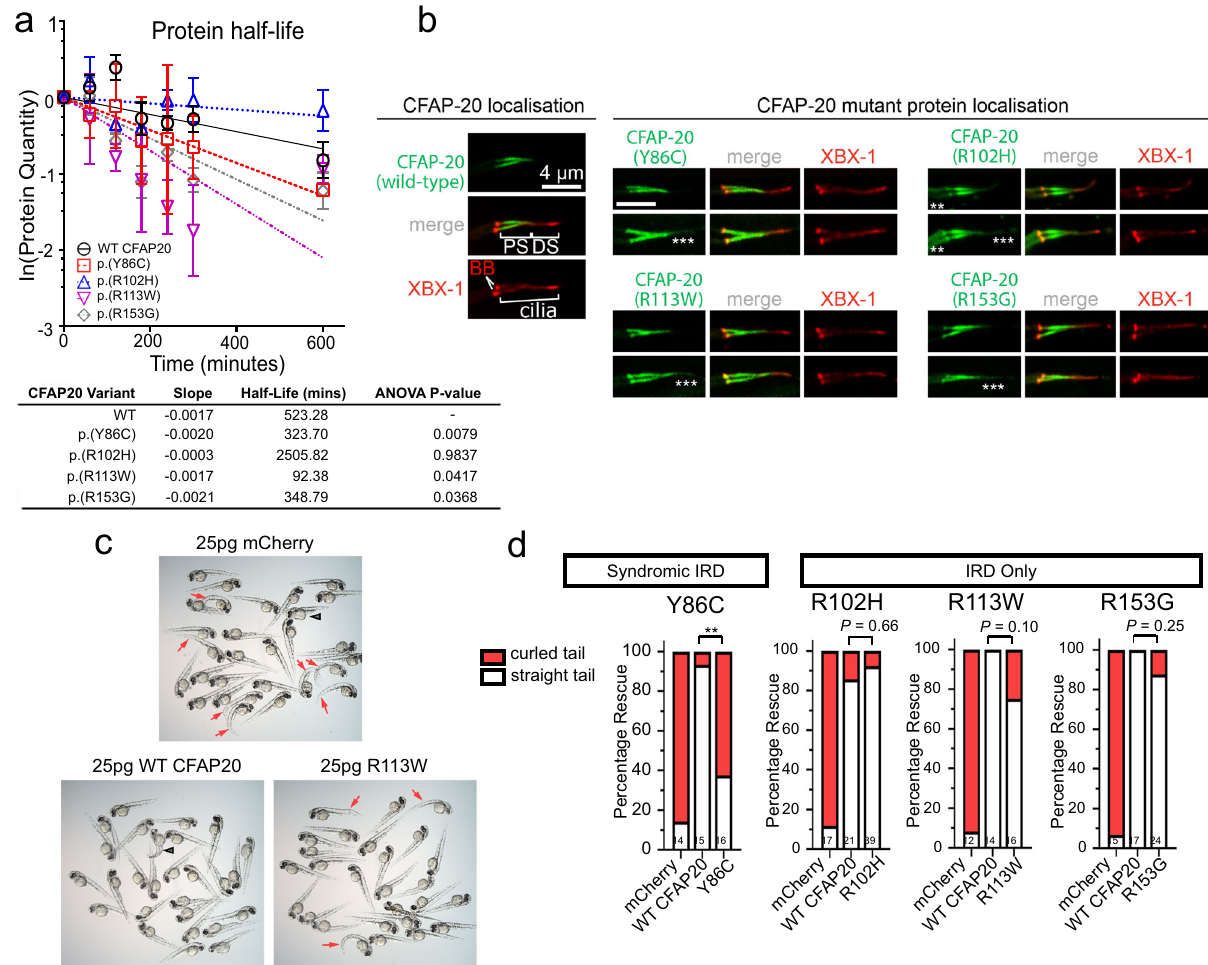
Fig. 6 | CFAP20 patient variant sequences variously cause altered protein sta- bility, mislocalisation in C. elegans and reduced ability to rescue zebra fi sh homozygote development. a Half life calculations assuming fi rst-order decay (ln([relative protein] t = x /[relative protein] t =0)). Lysates from transfected HEK293Tcellsrevealedasigni fi cant(one-wayANOVA)decayforallvariants,except forp.(Arg102His),comparedwithWildtype(WT)protein(half-lifeof~523min).The fastest decay was variant p.(Arg113Trp) with a half-life of ~93min ( n =3; error bars=SEM). b In C. elegans , human CFAP20 patient variants mislocalise in com- parison to wildtype CFAP20 . The GFP-tagged CFAP20 proteins bearing patient mutationsconcentratemostlytotheproximalsegment(PS)oftheaxoneme,which is similar to wild-type CFAP20 protein expressed in C. elegans . However, patient variants also mislocalise (asterisks) in the distal segment (DS) and/or the dendritic region to the left of the phasmid cilia (especially p.(Arg102His)). XBX-1 is an IFT reporter that marks the basal body (BB) and entire axoneme. c Wildtype human CFAP20 mRNA rescues zebra fi sh cfap20 mutants, as compared to control mRNA